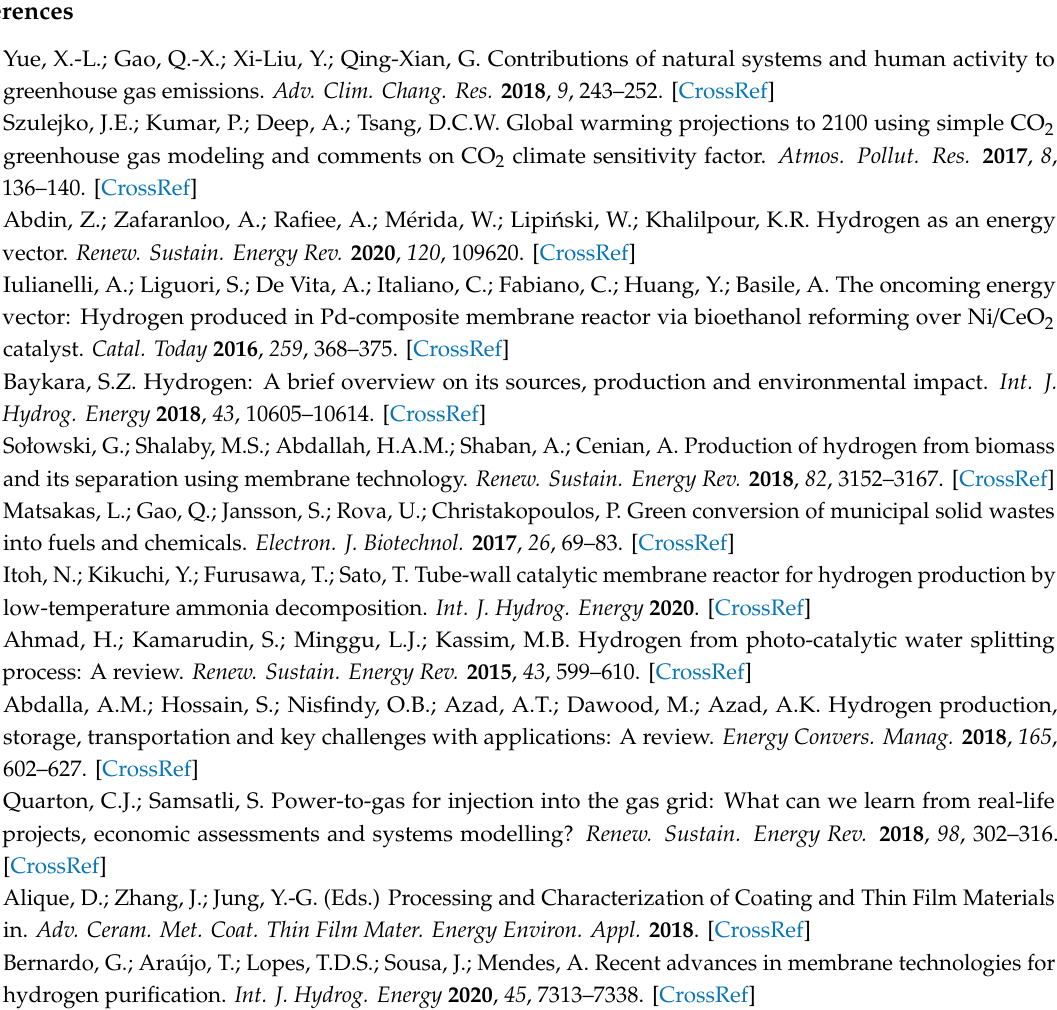
Figure S1: Validation of permeation measurements by testing three di ff erent membranes prepared at analogous conditions (PSS / GRAPH / Pd) under consecutive thermal